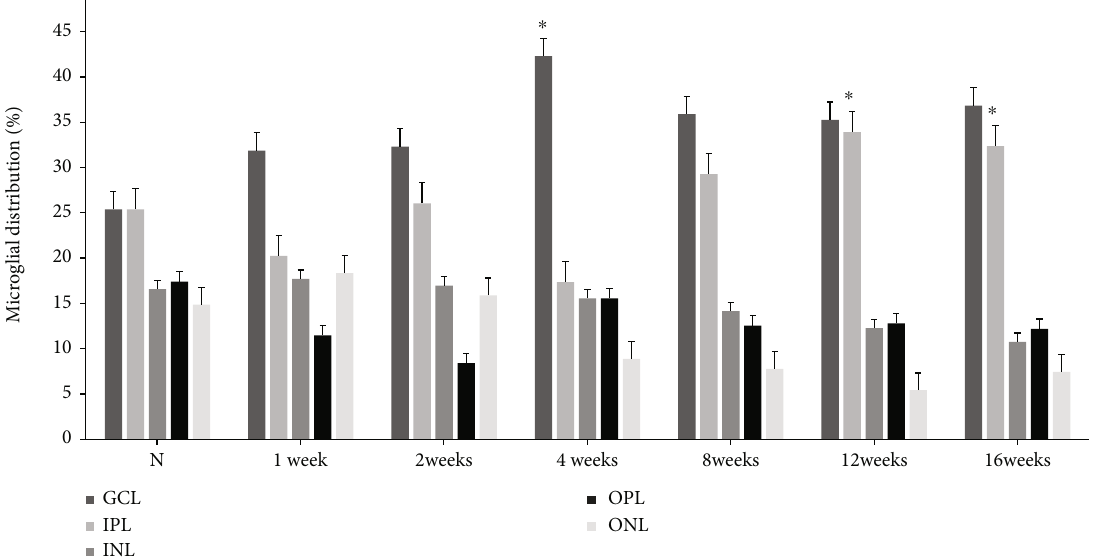
Figure 5: Retinal distribution of microglia in the retinas of control and experimental diabetic rats. In the retinas of 12-week diabetic rats, the proportion of microglia increased in the GCL with a concomitant change in the IPL compared with that in other groups. ∗ p < 0 : 05 versus other groups.